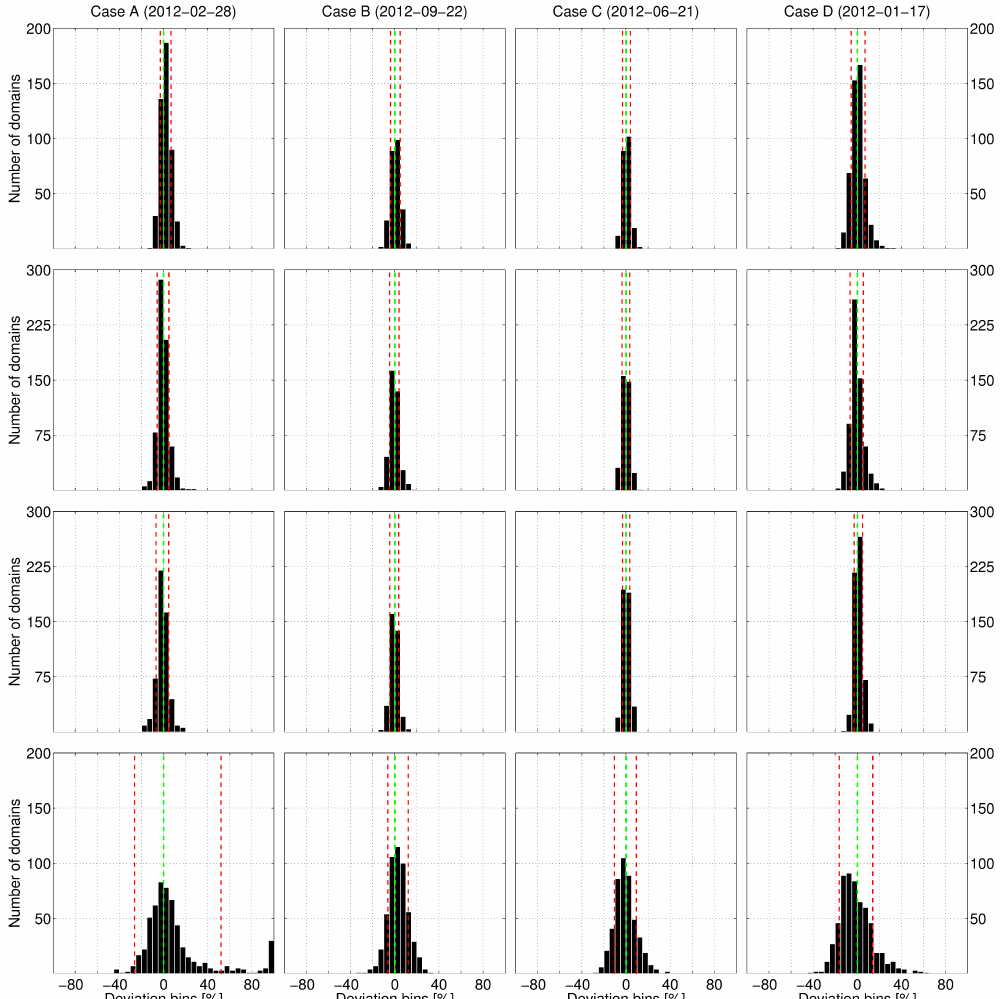
Figure 9. Histogram charts for estimating the error of TM approach in case study A (28 February 2012, first column), B (22 September 2012, second column), C (21 June 2012, third column) and D (17 January 2012, fourth column) with advection of H 2 O profiles from Aura MLS instead of ground-based measured profiles. The number of relative difference (TM MLS − MLS) domains in a certain deviation bin of a width of 5 % between TM MLS and Aura MLS solution is shown. From top to bottom the pressure layers are 12–8, 3 . 5–2 . 5, 1 . 3–0 . 7 and 0 . 13–0 . 07 hPa. Vertical green lines indicate zero deviation and red dashed lines mark the standard deviations ( ± σ